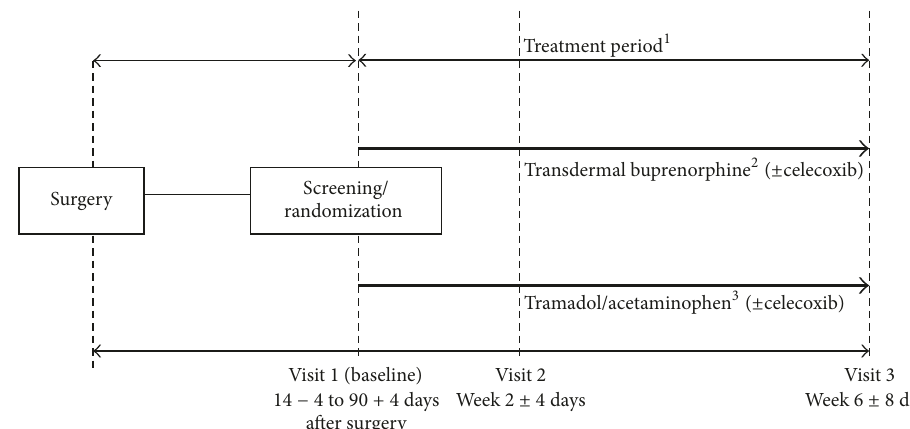
Figure 1: Study design and visit schedule . 1 Unscheduled visits could be conducted at any time during the treatment period. Domperidone maleate was concurrently prescribed for 2 weeks from initiation of the study drug administration. Subsequently, continued use was determined at the discretion of the investigator. 2 Permitted study drug dose escalation: transdermal buprenorphine (BTDS) 5 𝜇 g/h to 10 𝜇 g/h to 15 𝜇 g/h or 20 𝜇 g/h. 3 Permitted comparator drug dose escalation: tramadol/acetaminophen (TA; tramadol 37.5 mg/acetaminophen 325 mg) 1 tablet × 2 doses per day to 2 tablets × 2 doses per day to 3 tablets × 2 doses per day or 4 tablets × 2 doses per day. BTDS: buprenorphine transdermal system (NORSPAN); TA: